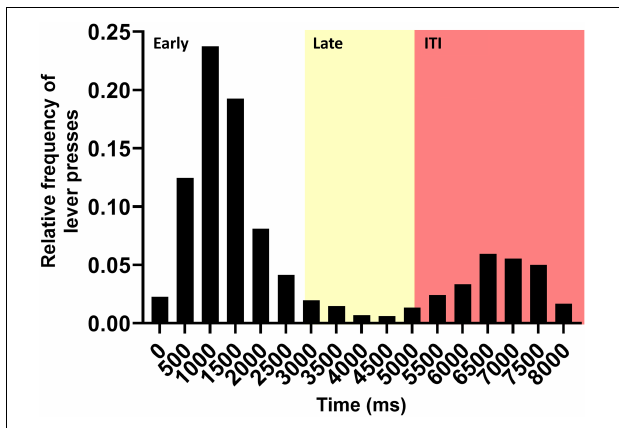
FIGURE 2 | Histogram showing the frequency of the responses during the baseline period of the protocol (days 1–4). The image shows the relative frequency of lever presses as a function of the trial elapsed time. Each bin of the histogram corresponds to a 500-ms window. The zero represents the beginning of the animals’ response time (lateral light onset). The first 5 s represent the time in which the animal received a reward if it pressed the correct lever, which was separated into an early response window (white) and a late response window (yellow). The last 3 s correspond to the time in which the animal did not receive a reward for pressing the correct lever (red).